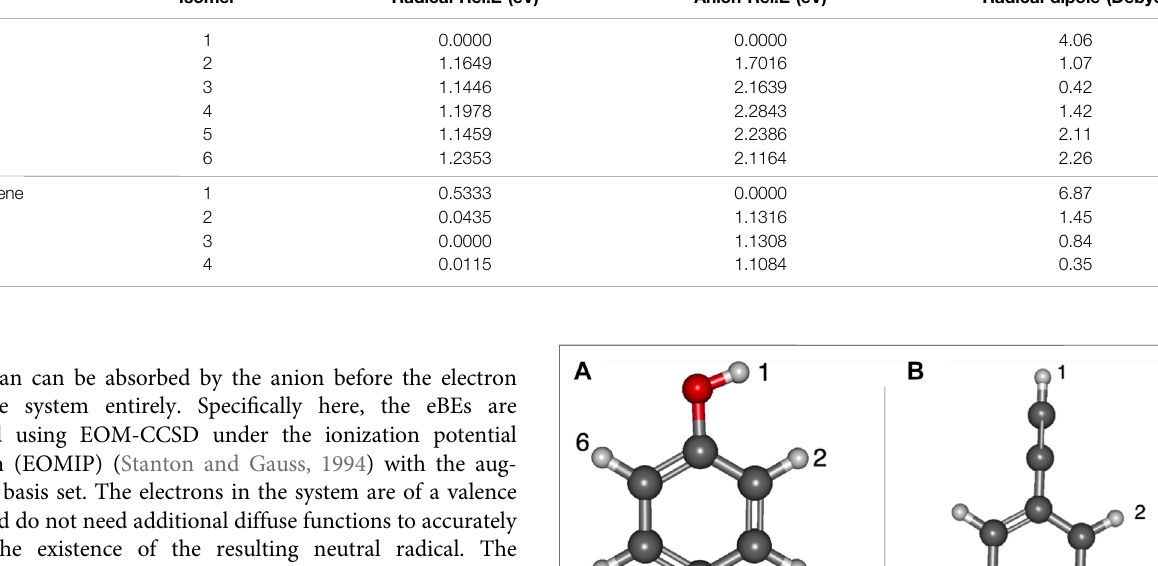
TABLE 1 | The relative energies and neutral radical dipole moments of singly deprotonated phenol isomers. Isomer Radical Rel.E (eV)